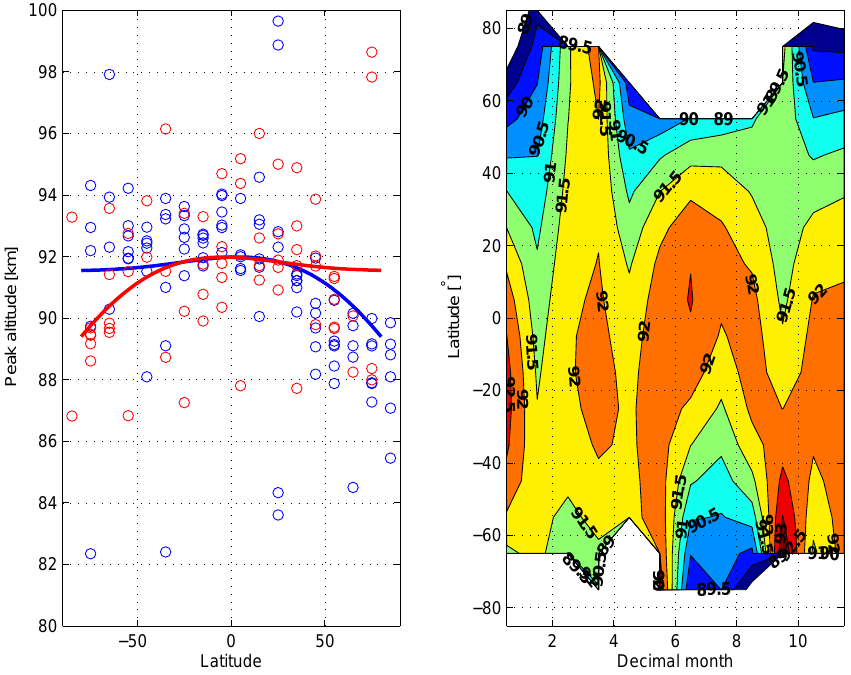
Fig. 12. Left panel: blue: retrieved peak heights (circles) in January and the approximate fit given by Eq. (9) (full line) showing the strong subsidence during polar winter; red: same data in July. Right panel: time-latitude isopleths for Na peak height.